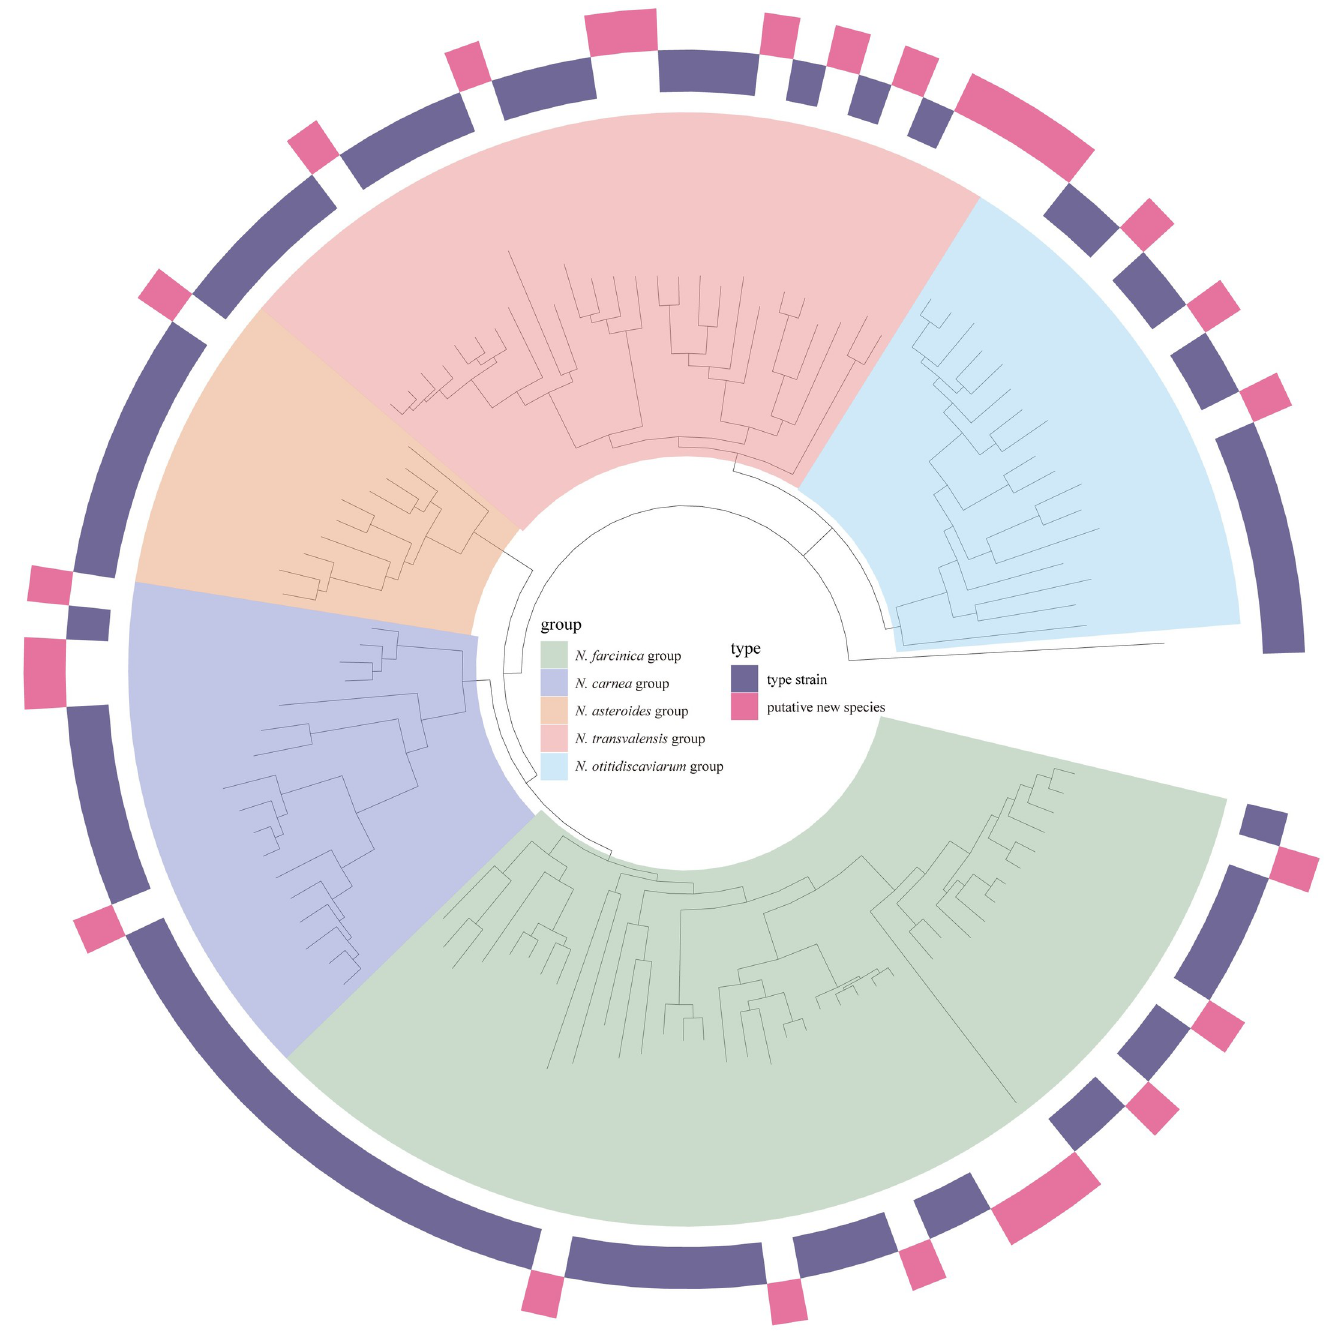
Fig 4. Phylogenomic tree of members of the genus Nocardia . A maximum-likelihood phylogeny tree was built based on the concatenation of 298 single-copy genes from 81 type strains and 28 putative new species with 1000 bootstrap replicates. The genome of Rhodococcus globerulus NBRC 14531 was included as an outgroup. Phylogenetic groups are highlighted in different